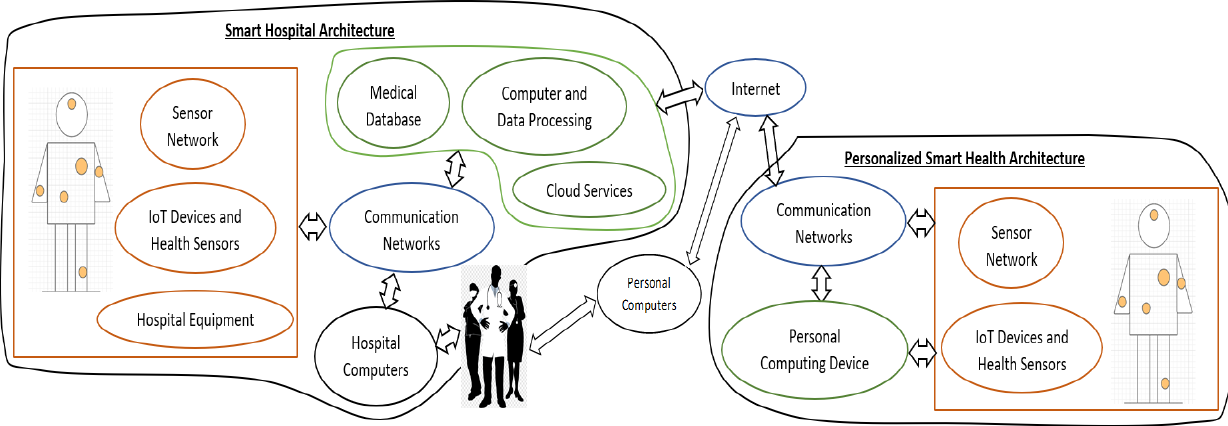
Figure 3. A general Smart Health architecture.